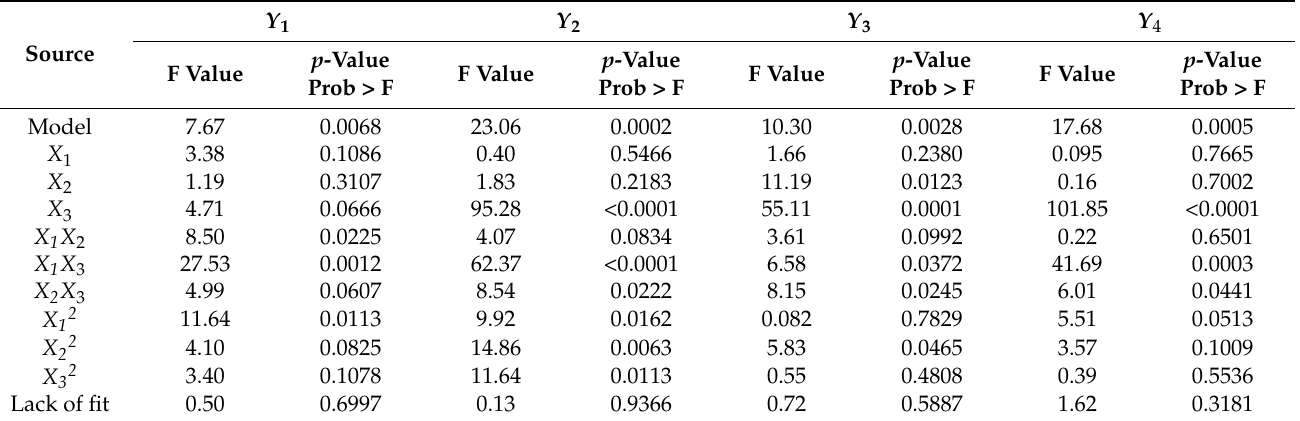
Table 5. ANOVA statistics of the quadratic model for the extraction yields of jolkinolide A, jolkinolide B, 17-hydroxyjolkinolide A and 17-hydroxyjolkinolide